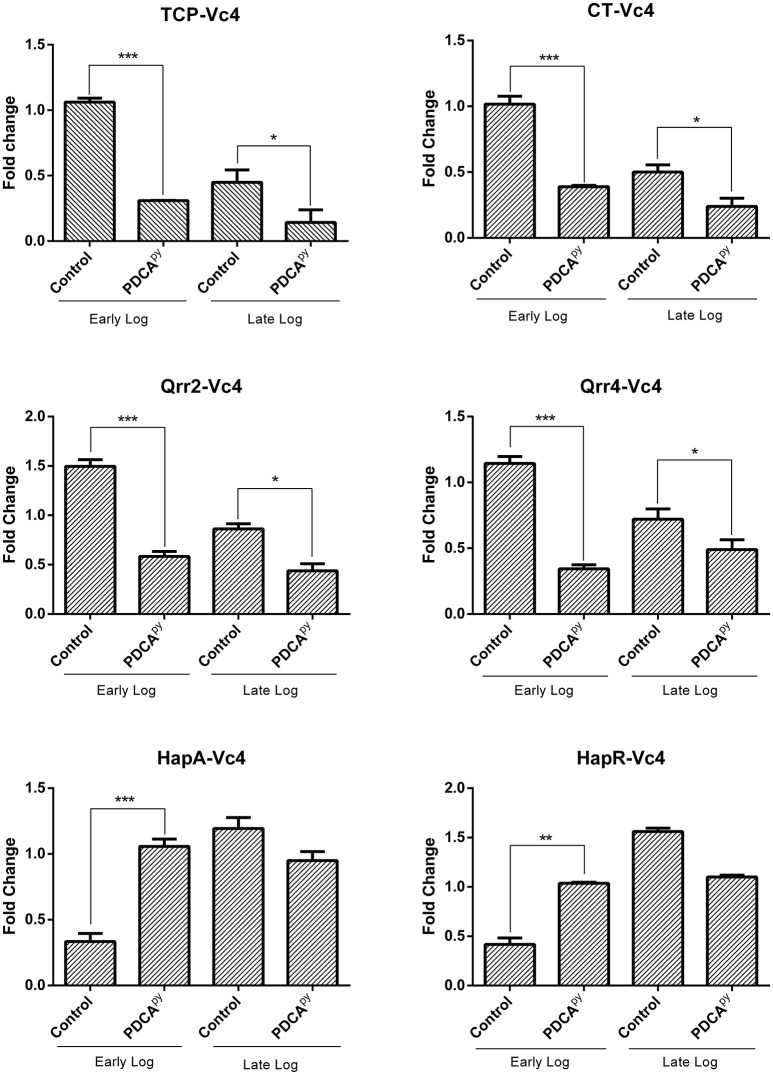
LuxO regulated gene expression analysis by qRT- PCR. The genes tcp, ct, qrr2, and qrr4 showed down-regulation and the up-regulation of hapR and hapA in the early log phase when treated with PDCApy suggesting premature activation of HCD condition at LCD state. At the late log phase (HCD state), LCD condition is retained in the case of PDCApy treated. 16srRNA was used as reference gene for normalization. Statistical significance denotes, ***p ≤ 0.001; **p ≤ 0.01; *p ≤ 0.05.